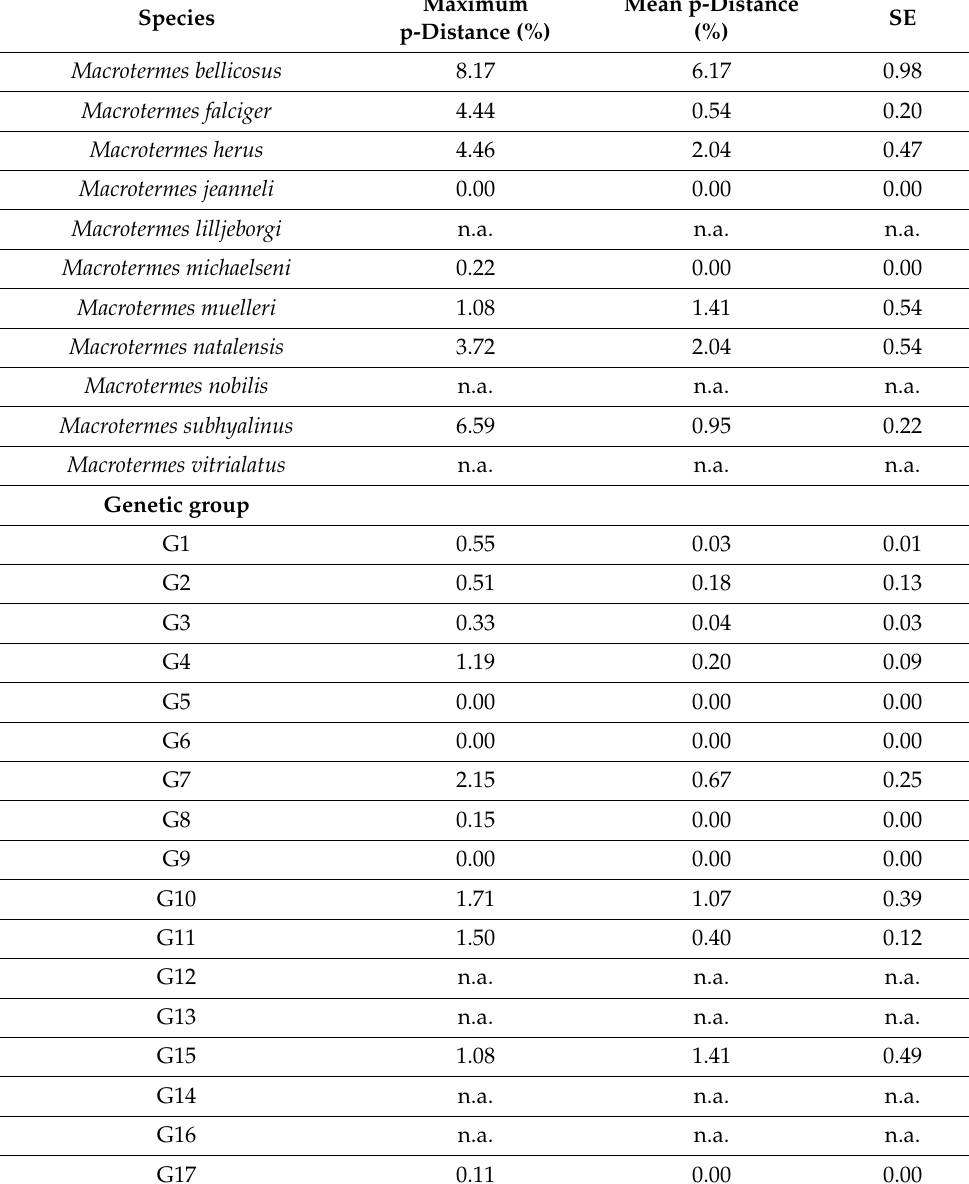
Table 2. Pairwise distances among different genetic groups of African Macrotermes . Species— sequences were grouped according to species names. Genetic groups—sequences were grouped according to phylogenetic